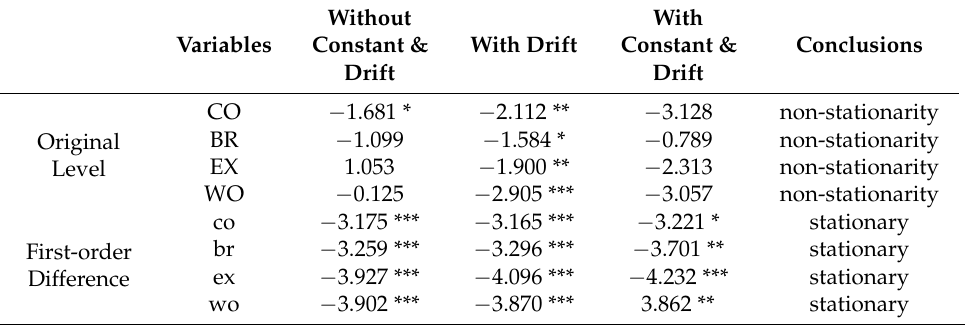
Table 1. Augmented Dickey–Fuller